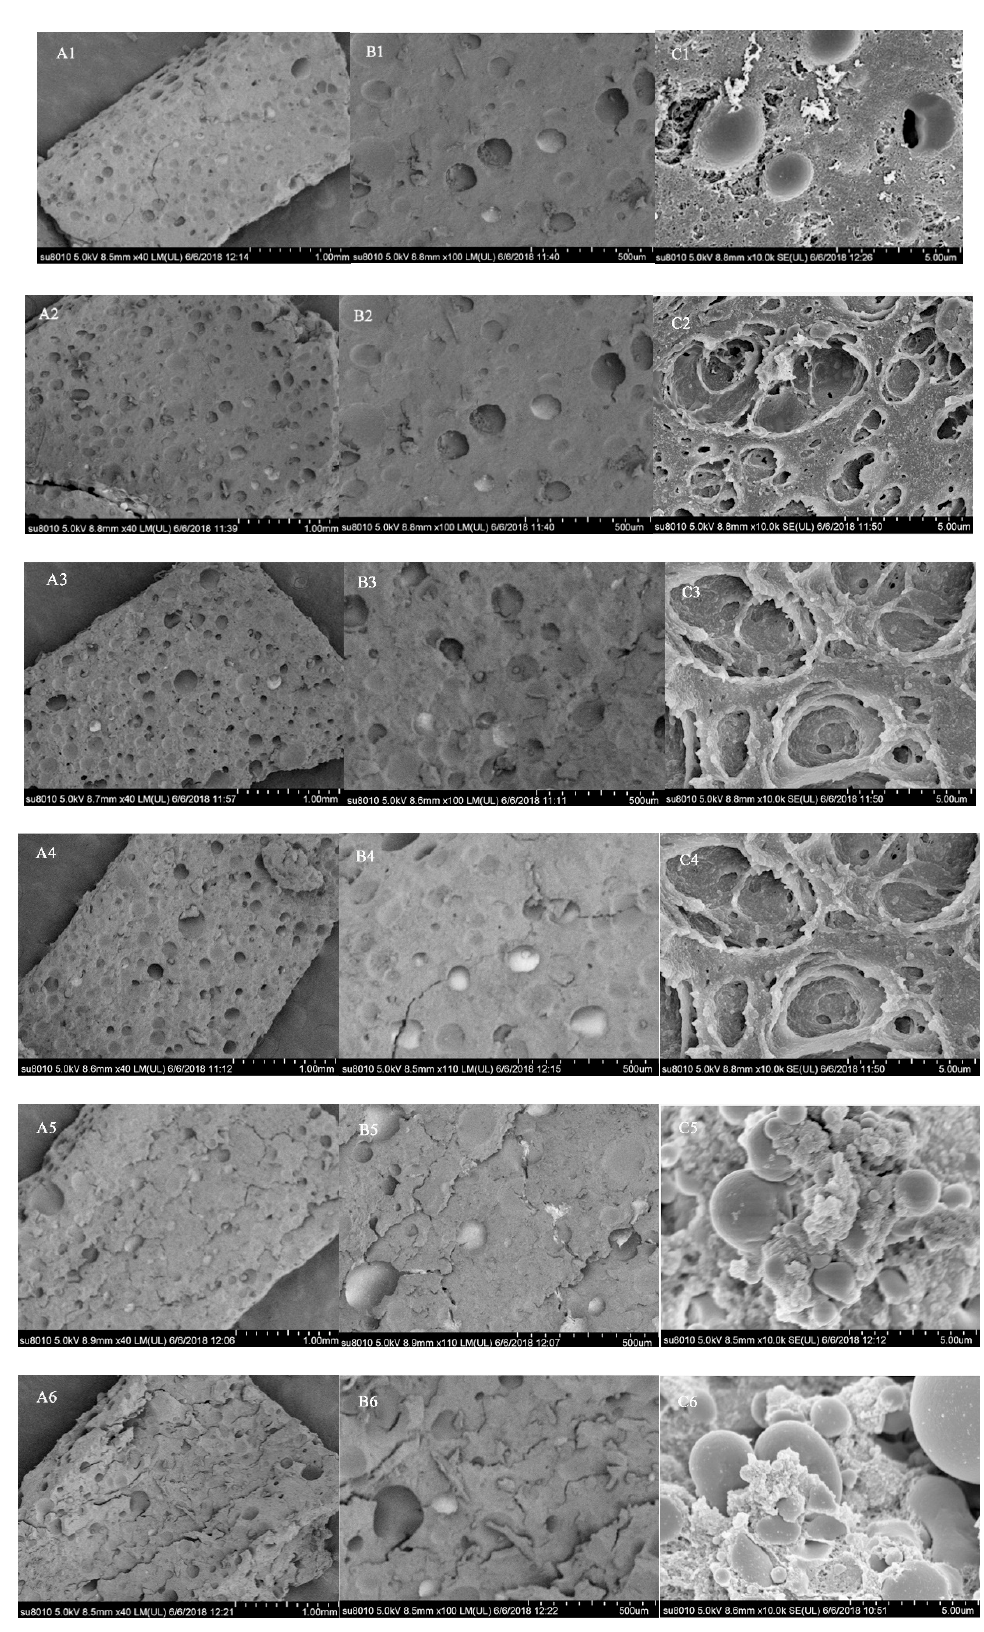
Figure 5. Scanning electron microscope of the Chiba tofu. Numbers 1, 2, 3, 4, 5 and 6 represent the samples of SPI that were stored for 0 days, 6 days, 12 days, 18 days, 24 days and 30 days, respectively. ( A1 – A6 , B1 – B6 , C1 – C6 ) represent the magnification of 40, 100 and 10,000.